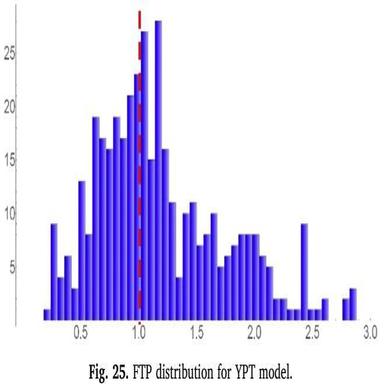
FTP distribution for RHT model.